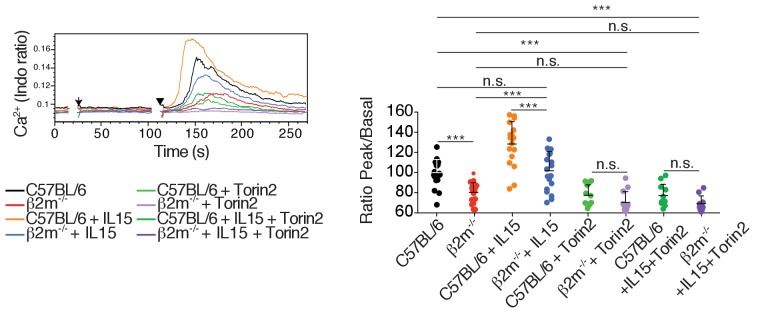
Left: Representative histogram overlay showing the Ca2+ flux intensity in splenic NK cells from C57BL/6 or B2m−/− mice with or without IL-15 (100 ng/ml) and Torin2 (500 nM).NK cells were activated following incubation with biotinylated anti-NK1.1 (Arrow) followed by cross-linking with streptavidin (Arrowhead). Right: Bar graph showing the Ratio Peak/basal normalized to the ratio of control NK cells (mean +SD of n = 12–20 replicates from 6 mice in six independent experiments, one-way ANOVA comparing the indicated conditions ***p<0.001, n.s. non significant).